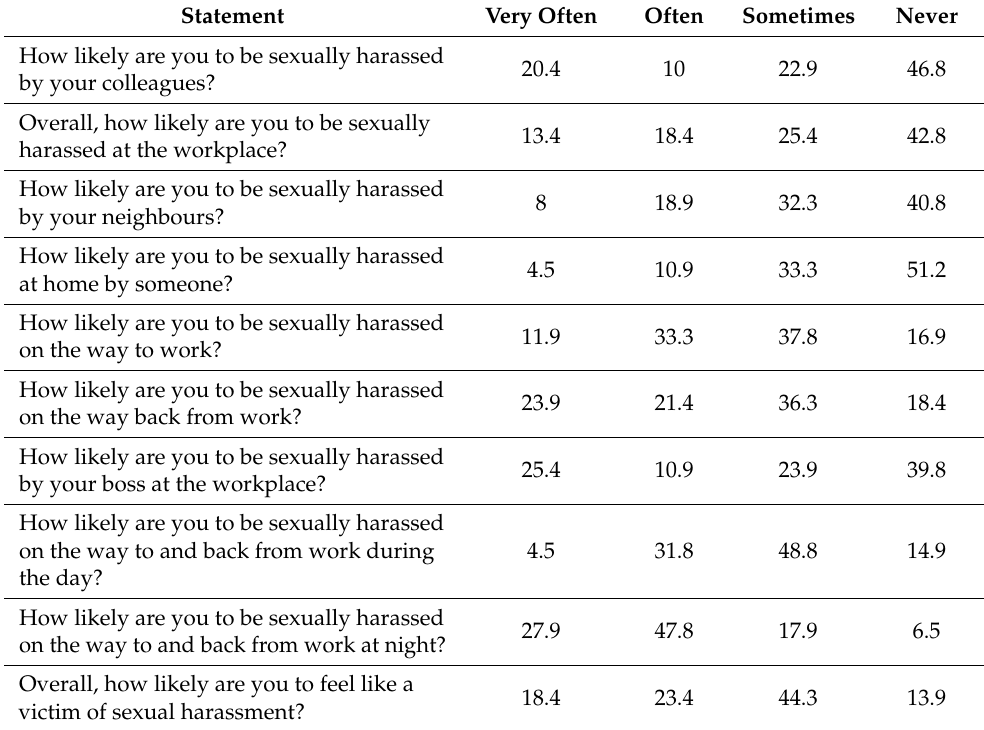
Table 3. Summary of statements related to sexual harassment [ n = 201].